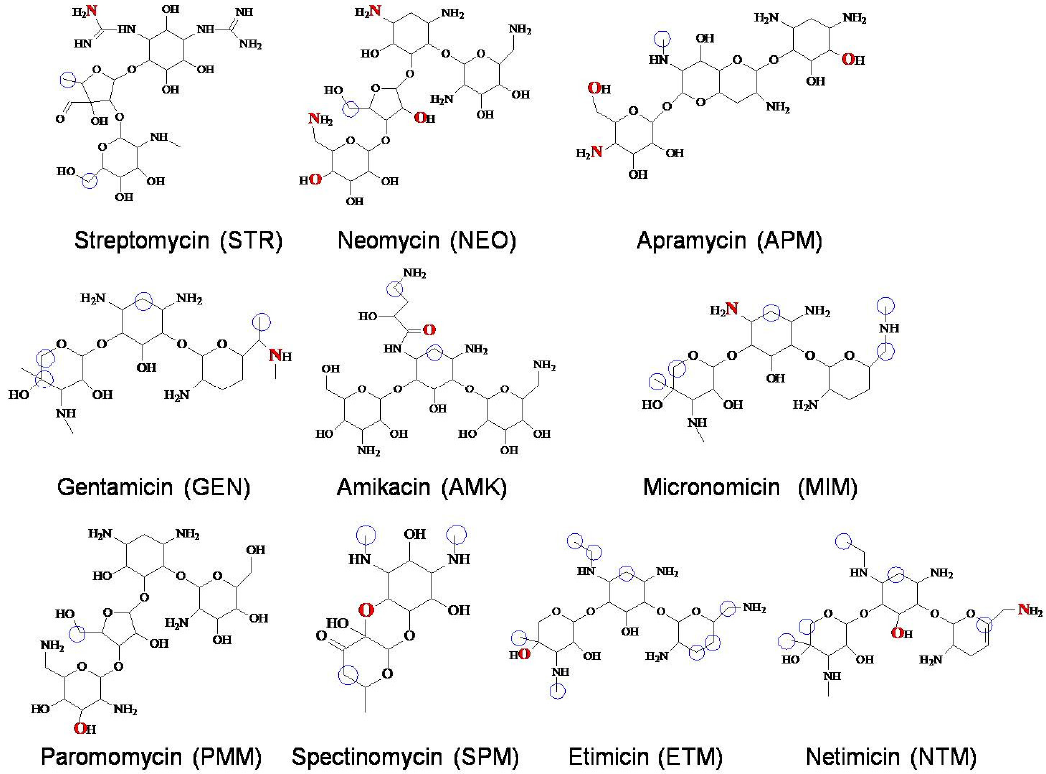
Figure 1. Molecules of the 10 AGs. (Atoms highlighted inred were the binding sites of hydrogen bond. Atoms highlighted with blue circles were the binding sites of hydrophobic interaction.).